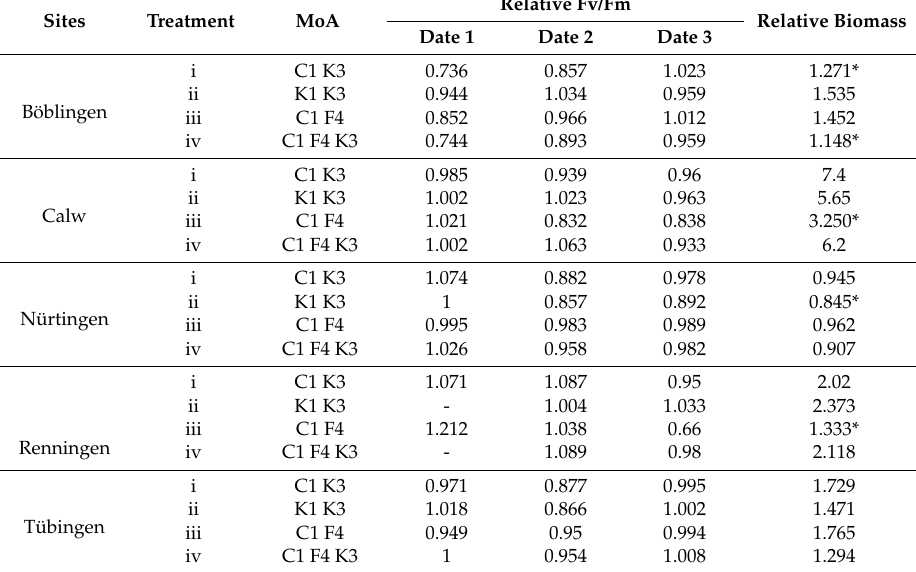
Table 4. The relative change of the Fv/Fm values and the dry biomass to the untreated control plants of each site and measuring date in the field experiment. The relative Fv/Fm values were calculated on the average Fv/Fm values of the treated plants by the average Fv/Fm values of the relative untreated control plants. MoA, Mode of Action; C1, Inhibition of PS II; F4, Inhibition of DOXP synthase; K1, Inhibition of microtubule assembly; K3, Inhibition of cell division (VLCFA); *, stress efficacy on biomass correlated to significantly different Fv/Fm values in both